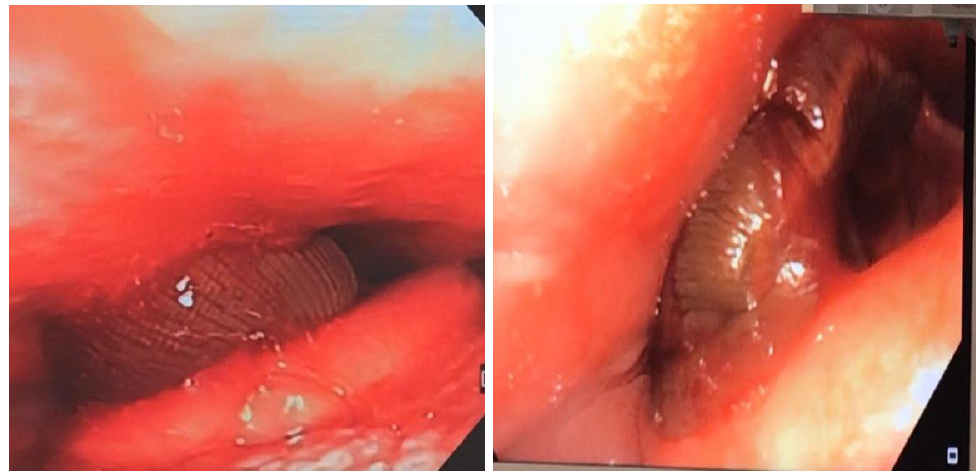
Figure 1. The presence of a leech in supraglottic area.